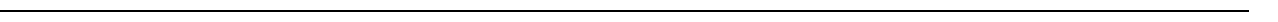
Fig. 1 Recording sites, connectivity, and color stimuli. a To identify the correct color of an object, e.g., an apple (left), local hue information (right) needs to be integrated with global shape information. b Schemes for co-representing color and object shape information in visual system. Initially, before the visual system has explicitly segmented objects, color information and object shape information are largely entangled, with individual cells participating in the coding of multiple hues and object shapes. Two main strategies could be used to represent colored-objects in an organized way: (1) segregation of color and object information into parallel channels, resulting in object shape-invariant color-selective units and color-invariant shape selective units (top); (2) formation of units sharply tuned to both color and object shape (bottom). c Coronal and sagittal slices showing location of fMRI-identi fi ed face (blue) and color patches (yellow) in one monkey (M2) targeted for recording; dark-black line indicates electrode. The most anterior color patch was not observed with fMRI using the color localizer in this animal, and was located by electrical microstimulation in ALC (bottom panel, changes in BOLD signal of the identi fi ed voxels during microstimulation shown below). d Comparison between color patches identi fi ed by color localizer (top) and by microstimulation (bottom). The contrasts are overlaid on high-resolution coronal slices. Asterisk (*) indicates the stimulation site (ALC). The anterior – posterior position of each slice in mm relative to the interaural line is given in the top right corner. e 82 images of 10 categories were used (see Supplementary Fig. 2a for all the stimuli). Each image underwent a series of transformation in hues. For each pixel of the image, luminance was kept constant, while chromatic coordinates (CIE 1960) fell on a circle with the same distance to “ white ” ( fi lled circle) as the original pixel. Eight hues with different angles were used (open circles, starting from 0°, going clockwise at 45° step). A grayscale image with the same luminance and the natural color image were also